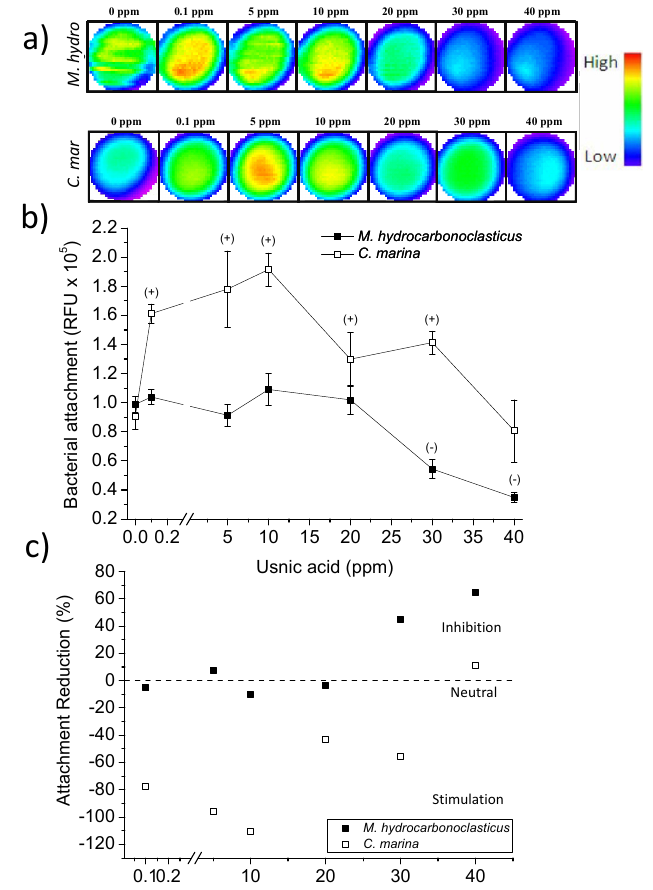
Figure 6. The effect of usnic acid on C. marina and M. hydrocarbonoclasticus attachment where: ( a ) is the well scan images of individual wells (scan matrix dimension: 30 × 30, equivalent to a resolution of 213 μ m × 213 μ m, scan width 6 mm); ( b ) End point fluorescence intensity (units: relative fluorescent units, RFU). Positive/negative (+/ − ) symbols indicate a significant increase (+) or decrease ( − ) in the attachment of the species when compared with the control at 95% confidence intervals. Syto9: excitation λ = 485 nm, emission λ = 510 nm. Error bars ±STDEV; ( c ) Attachment reduction according to RFU values, as a percentage of the control (0%, dashed line), where negative values indicate increased attachment and positive values,